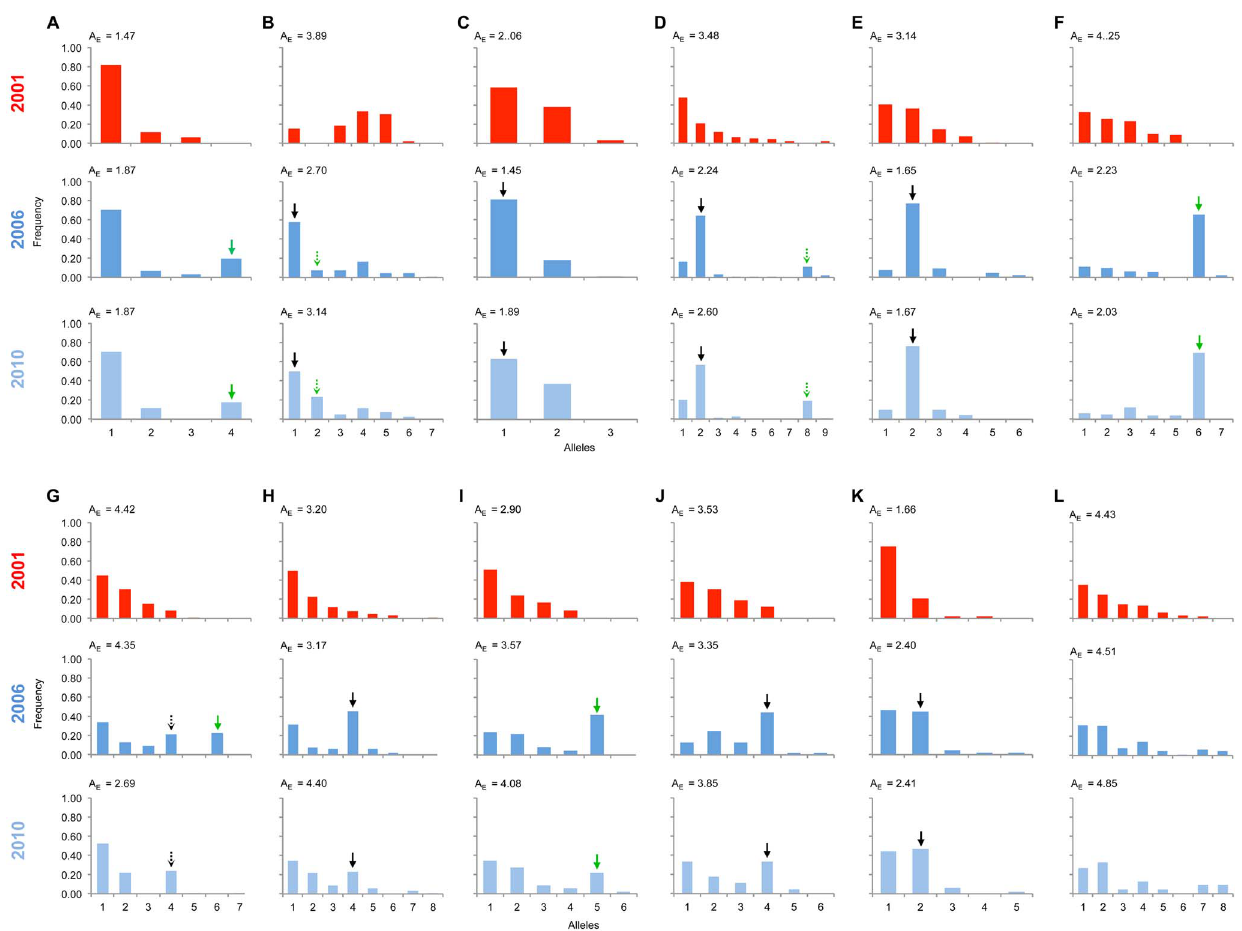
Figure 3. Allele frequency distributions across the linkage group carrying the suppressor in 2001, 2006 & 2010. The major allele variant for each locus (A-L) that has increased in frequency during the sweep is indicated with a solid arrow, while the secondary allele that increases (in 3 cases) is indicated with a dotted arrow. Where the allele is novel in 2006/2010 the arrow is green. Results of statistical comparison presented in S1 Figure. Effective allele numbers (A E ) are indicated on each